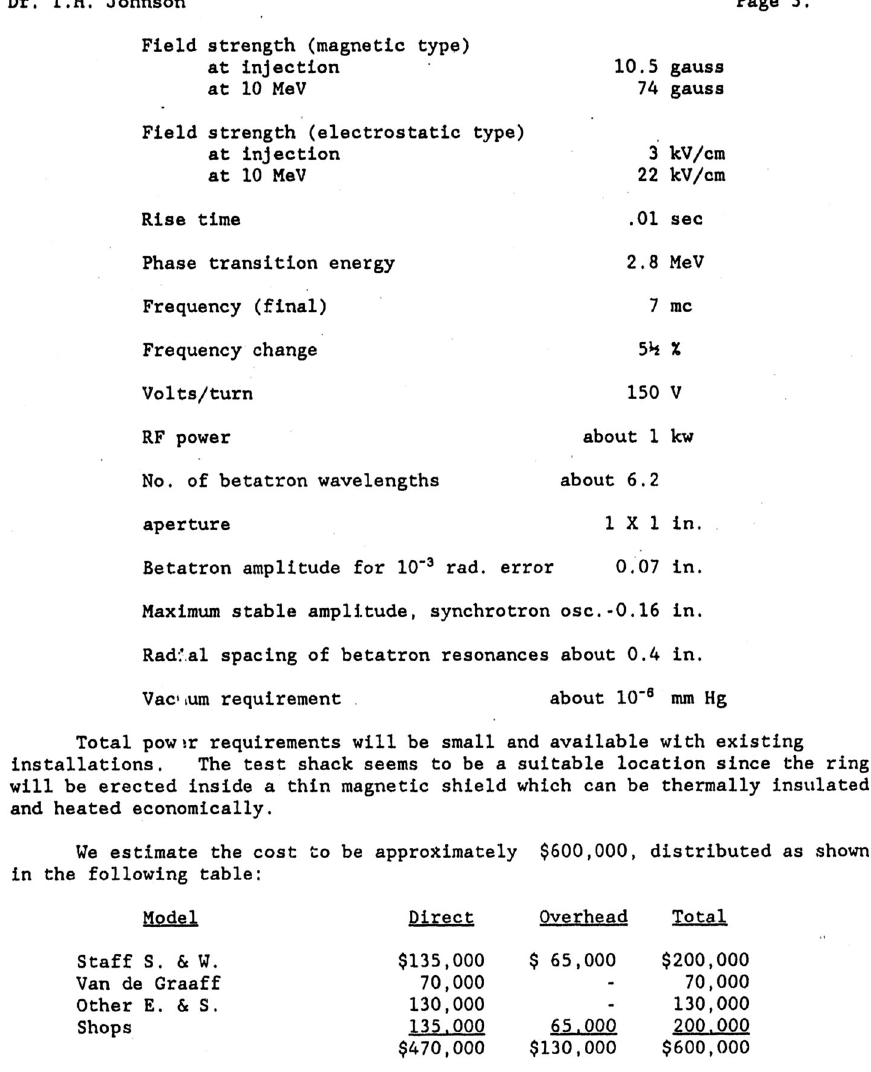
FIG. 10. Haworth letter, page